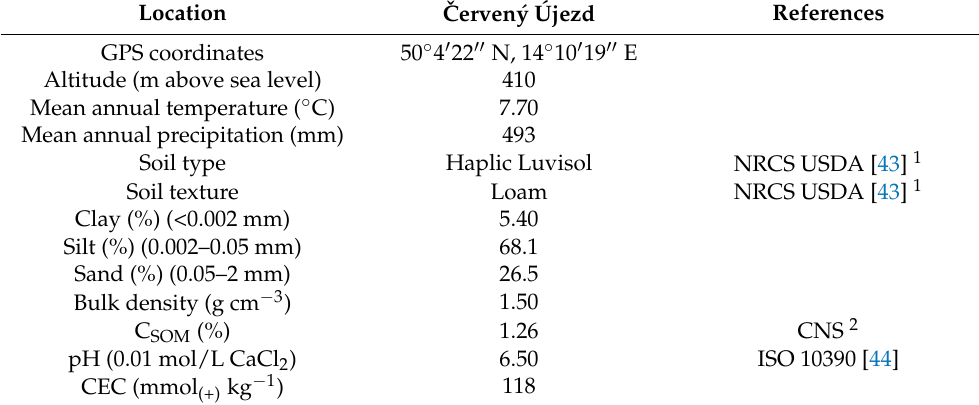
Table 1. Basic description of the ˇCerven ý Ú jezd experimental site at the start of the experiment. Location